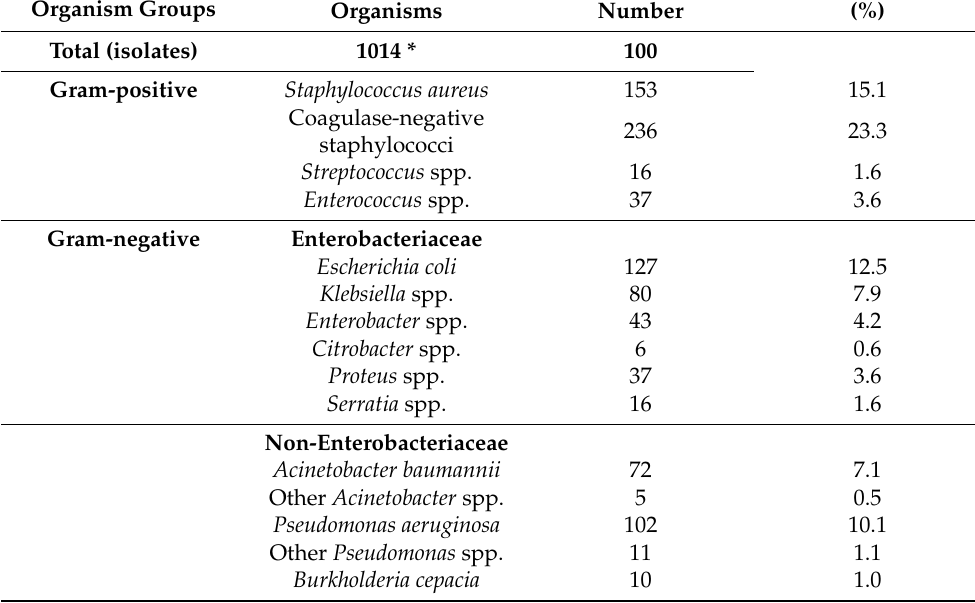
Table 1. Bacterial isolates from wound cultures at Yangon General Hospital, Myanmar, in 2018.